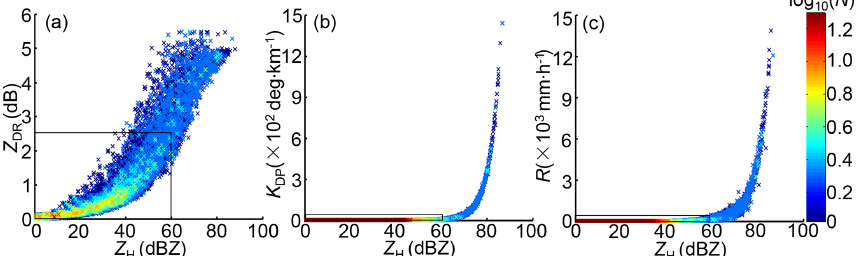
Figure 7. The scattergrams of DSD-derived polarimetric radar variables without QC processing: (a) Z DR vs. Z H , (b) K DP vs. Z H , (c) R vs. Z H . The rectangles in (a–c) indicate the ranges of DSD-derived variables after final QC processing.